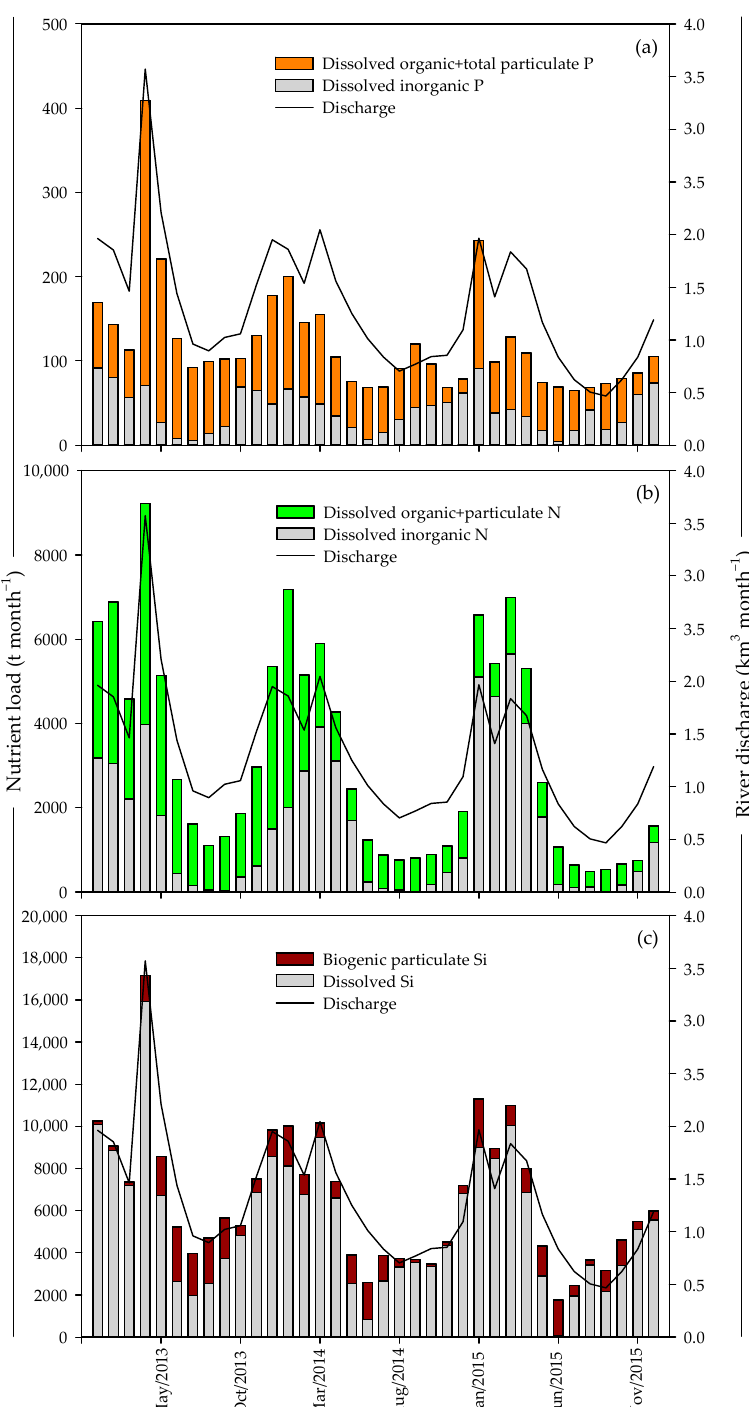
Figure 2. Monthly nutrient loads of dissolved and particulate phosphorus ( a ), nitrogen ( b ), and silica ( c ) measured at the Nemunas River gauging section in the 2013–2015 period. The monthly Nemunas River water flow means are also reported.